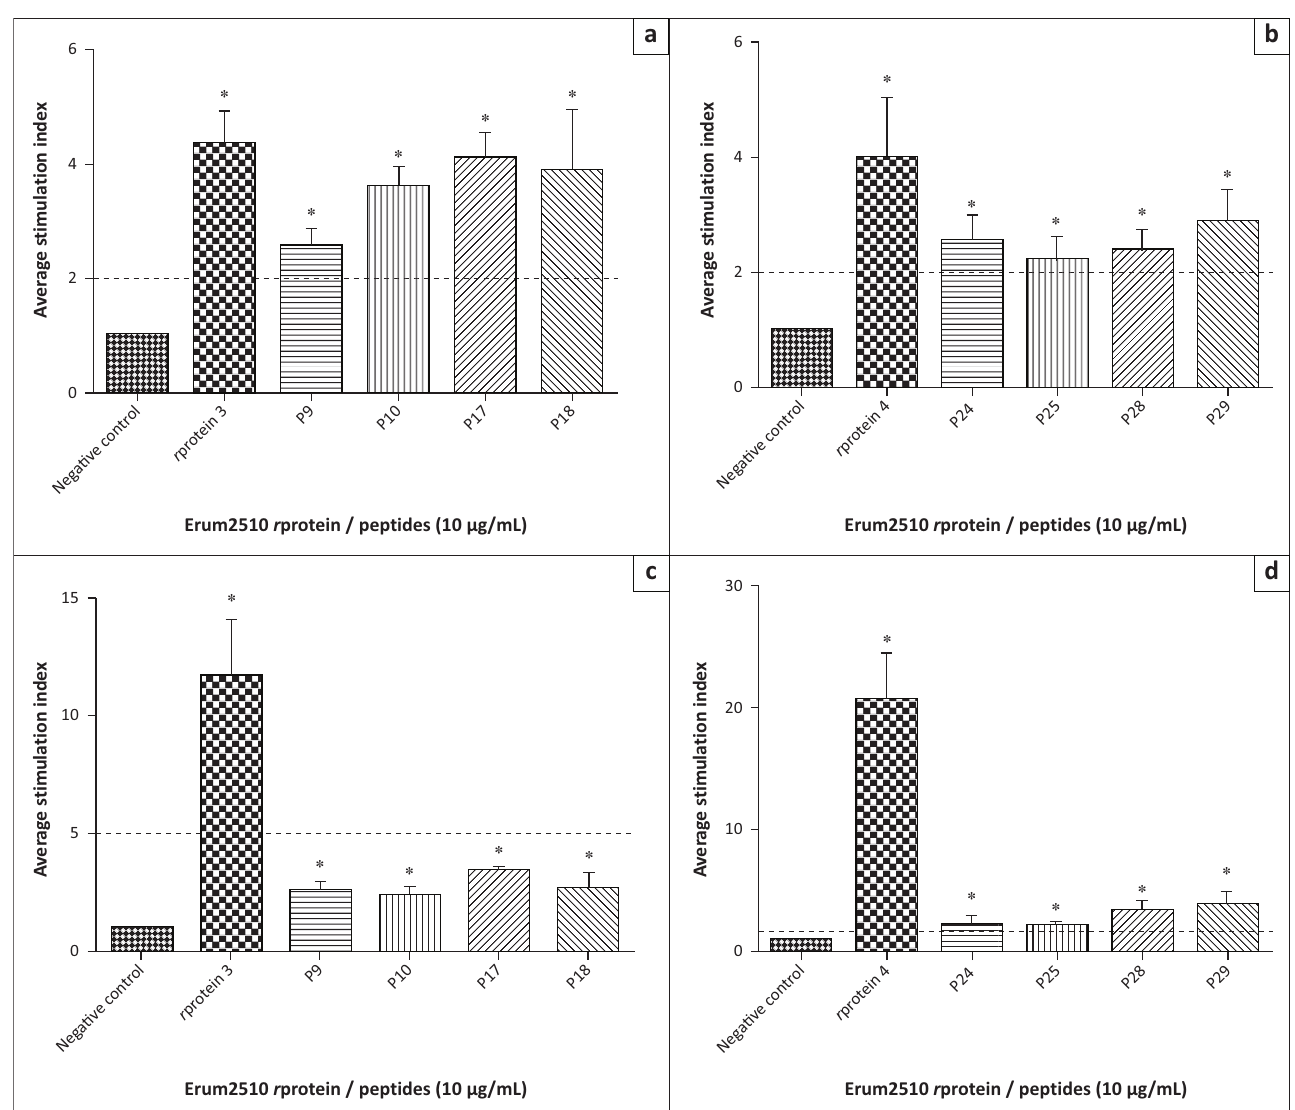
FIGURE 5-A1: Average stimulation index of immune peripheral blood mononuclear cells isolated from sM2 (a, b) and s6823 (c, d) after incubation with Erum2510 rproteins and peptides. (a, c) rprotein 3 and corresponding peptides; (b, d) rprotein 4 and corresponding peptides. Unstimulated peripheral blood mononuclear cells were included as negative control. The horizontal dashed line represents a stimulation index of 2, which is the cut-off point for a positive